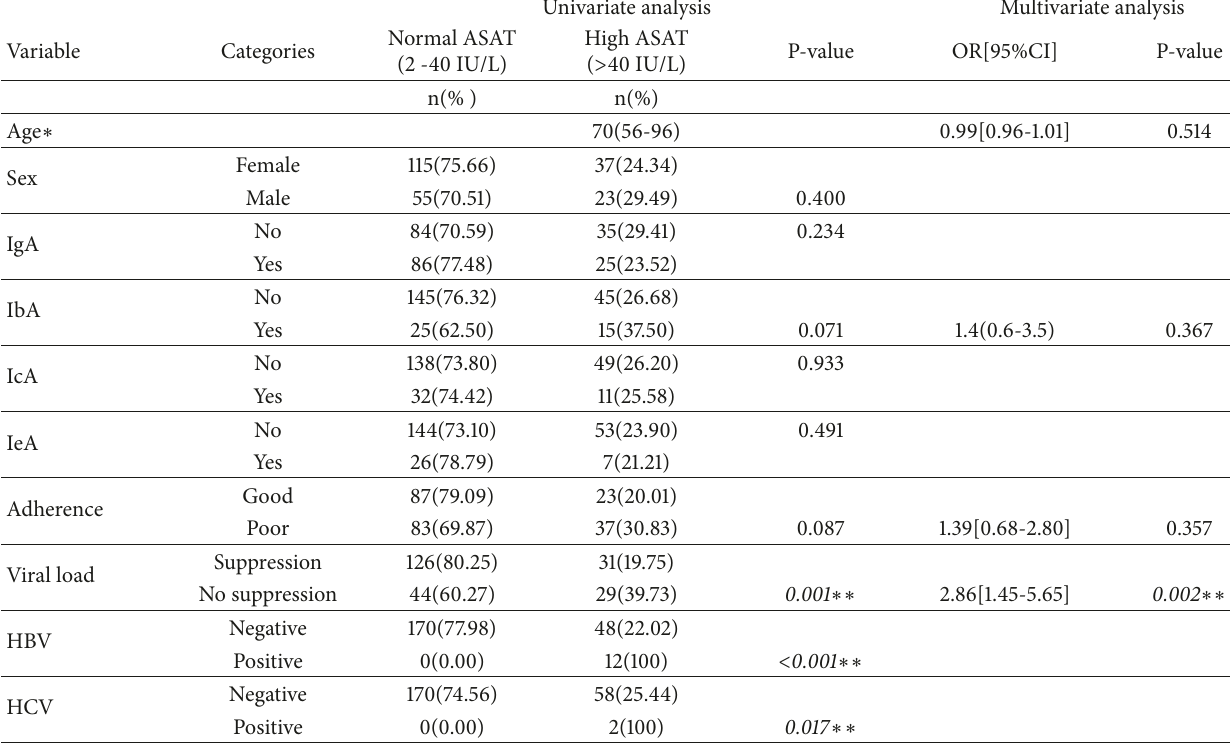
Table 2: Factors associated with high ASAT levels among HIV positive individual in the lake zone (N=230). Univariate analysis Multivariate analysis